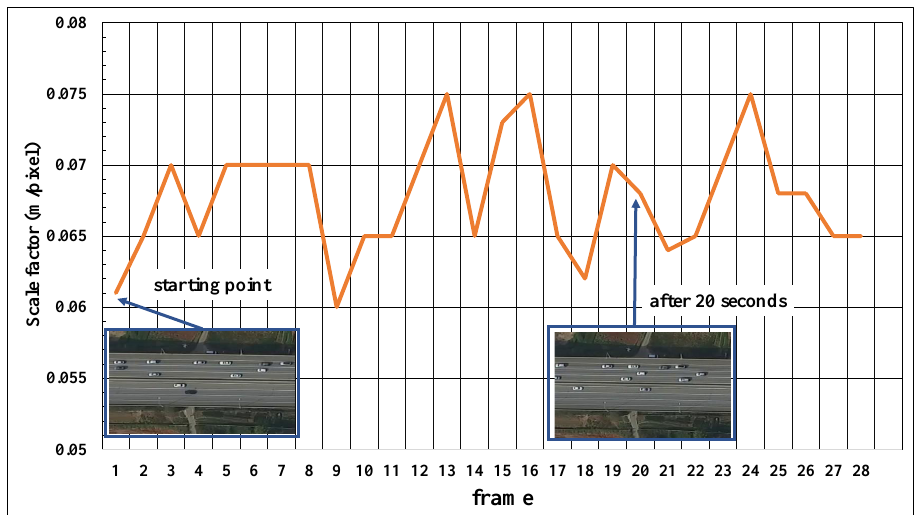
Figure 9. Scale factor ( s ) calculation result.